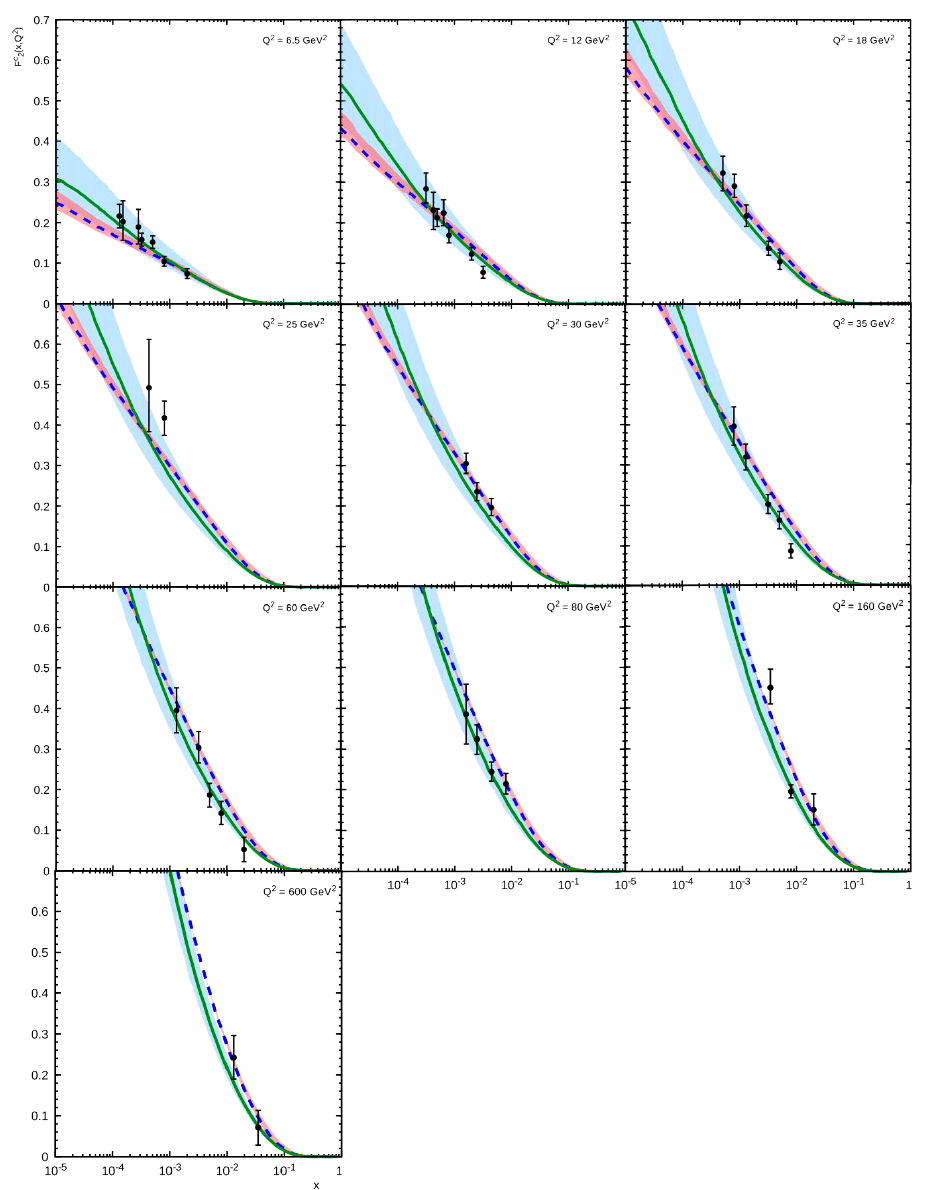
Figure 4. The charm contribution to the proton structure function F 2 ( x, Q 2 ) as a function of x calculated at different Q 2 . Notation of the histograms is the same as in Fig. 1. The experimental data are from ZEUS [21] and H1